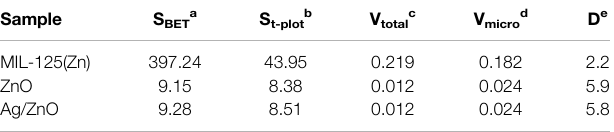
TABLE 1 | Textural parameters of MIL-125(Zn), ZnO, and Ag/ZnO. Sample